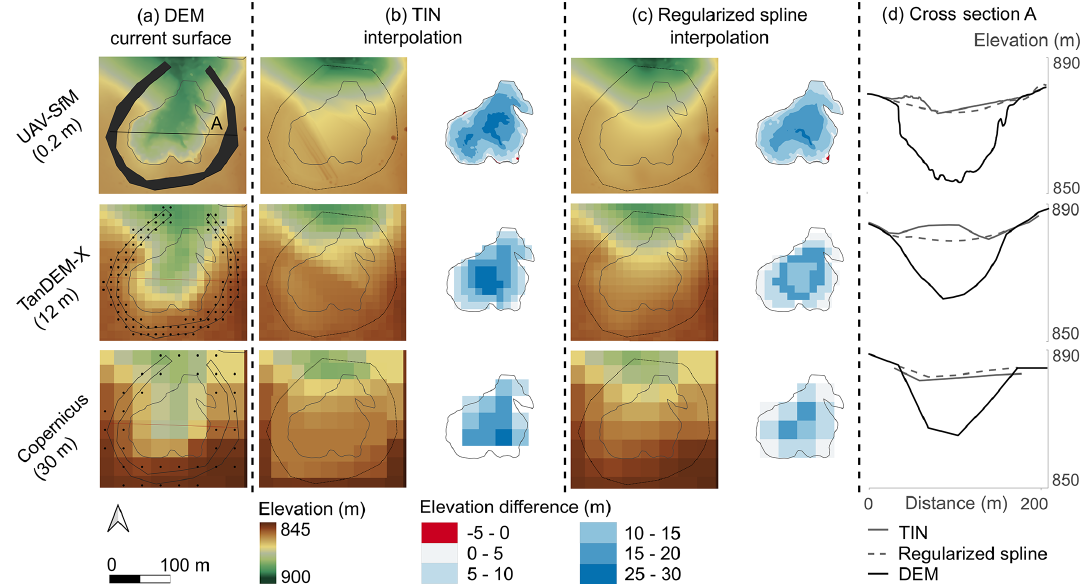
Figure 2. Lavaka volume determination workflow. Lavaka volumes were calculated for each individual lavaka following an automated workflow for the three studied DEMs: UAV-SfM (0.20m, top row, data collected June 2018), TanDEM-X (12m, middle row, Krieger et al., 2007) and Copernicus (30m, bottom row, AIRBUS, 2020a). (a) The digitized lavaka outline (grey), manually determined horseshoe-shaped polygon on the unaffected hillslope surrounding the lavaka, and current DEM are the three required inputs for the automated volume proce- dure. The DEM pixels that are not affected by erosion are clipped from the DEM with the horseshoe-shaped polygon and a single point per pixel is generated. The pre-erosion surface is then reconstructed by interpolating between these points (step 1). Two interpolation methods are shown as an example here: triangulated irregular network (TIN) (b) and regularized spline (c) interpolation. The grey polygon indicates the outer edge of the interpolated area. The elevation difference between the interpolated pre-erosion surface and current DEM surface is then calculated, which is clipped to the lavaka extent (Step 2–3). (d) Cross sections of transect A for the DEM, TIN, and regularized spline